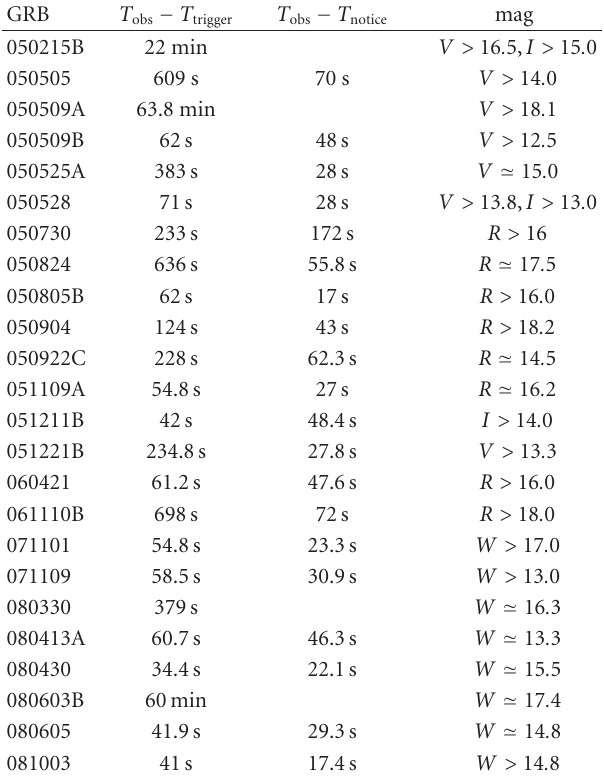
Table 1: Summary of GRBs successfully followed by BOOTES-1B.